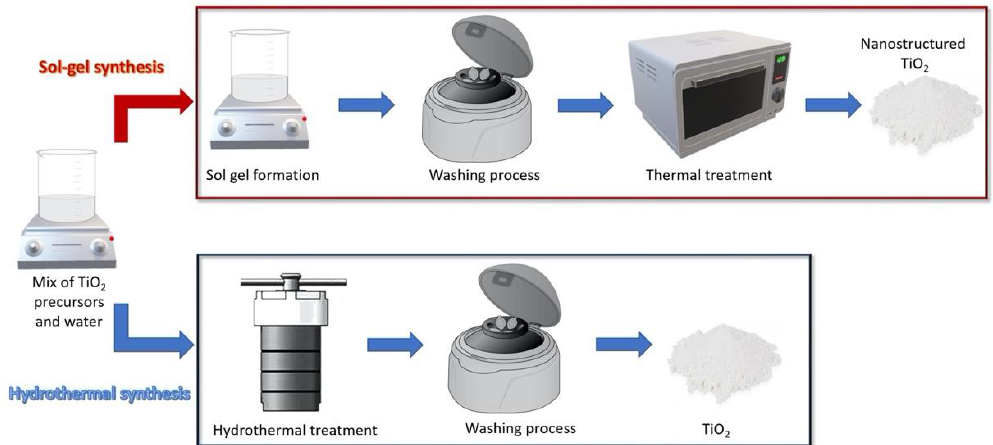
Figure 1. Schematic representation of TiO 2 NPs sol-gel method (upper panel) and hydrothermal synthetic approach (lower panel).